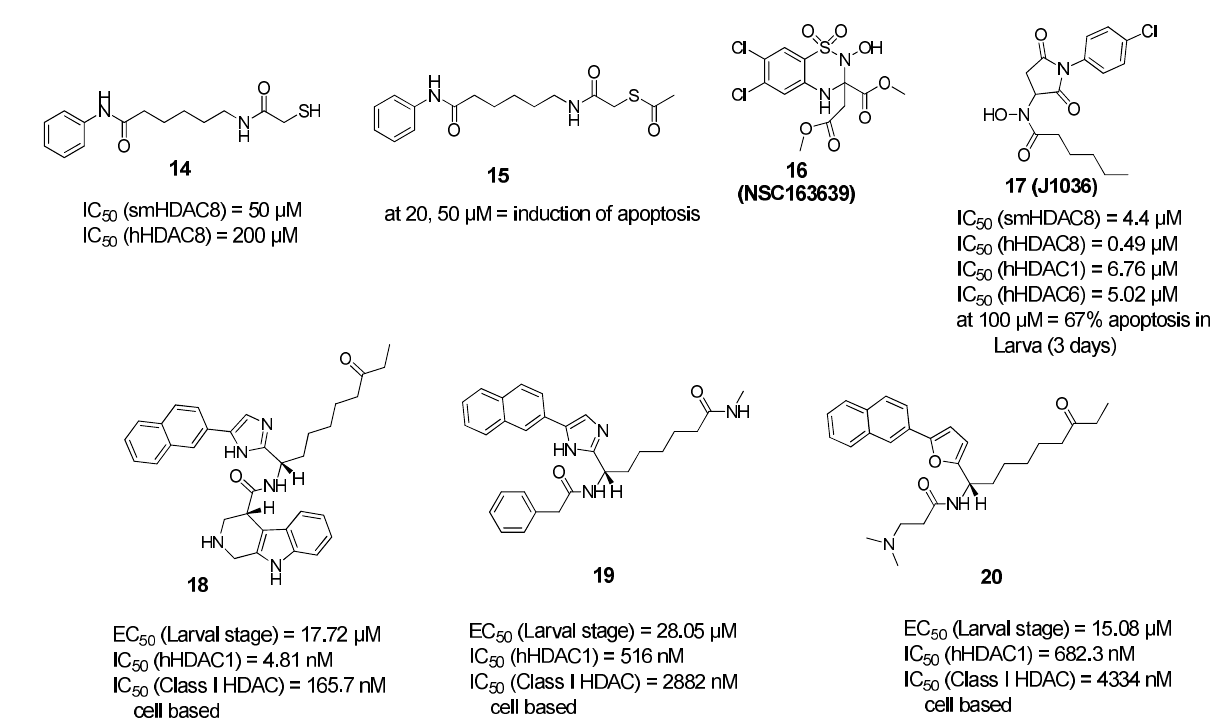
Figure 3. Examples of non-hydroxamic acid smHDAC8 inhibitors .